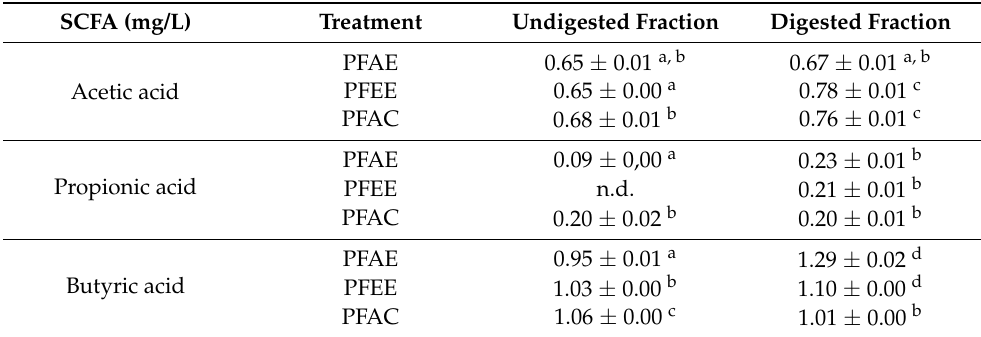
Table 5. Short chain fatty acid (SCFA) profile of probiotic fermented supernatants from treated persimmon fiber